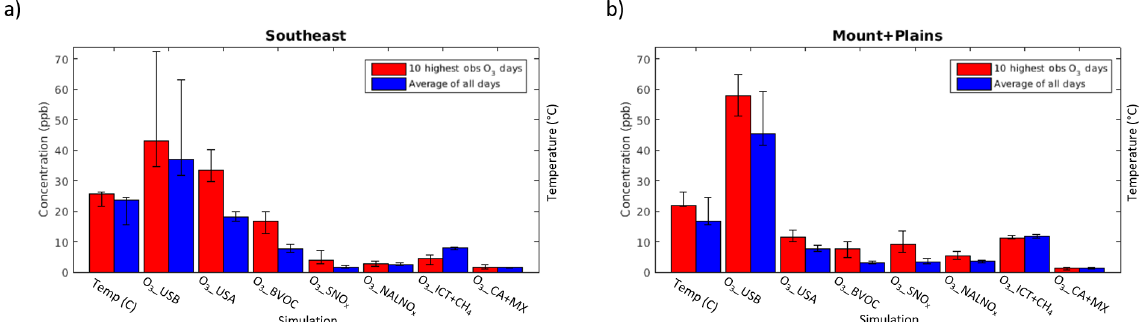
Figure 5. Average 2004–2012 influence of each sensitivity simulation on O 3 _Base in the (a) Southeast and (b) Mountains and Plains regions on MDA8 O 3 _top10obs_JJA days (red) versus averaged across all days (blue). Error bars show the concentration on the lowest versus highest year for each sensitivity simulation in each region. Daily 24h average temperature is also shown.